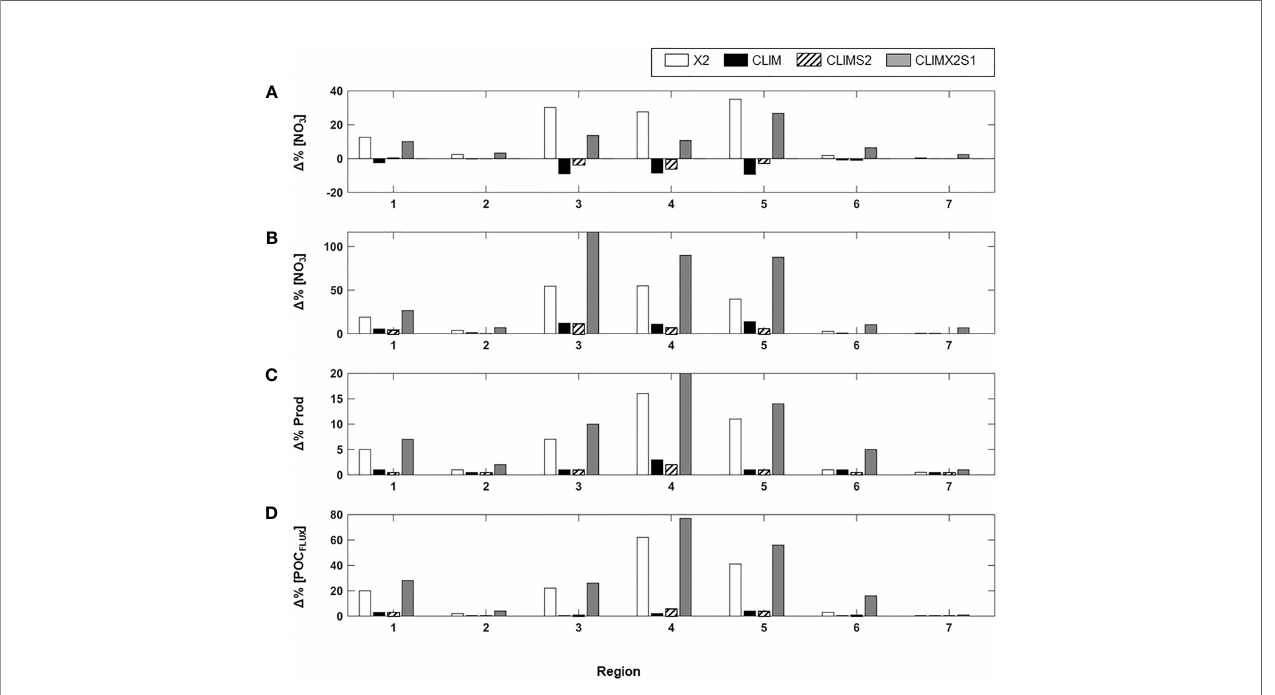
FIGURE 4 | Percentage change to (A) spring mixed layer nitrate, (B) spring mixed layer nitrate, (C) vertically integrated annual primary production, and (D) Annual fl ux of POC to the sediment arising from each of the reiver nutrient experiments. Percent changes are shown for each of the seven coastal regions (see Figure 1D for